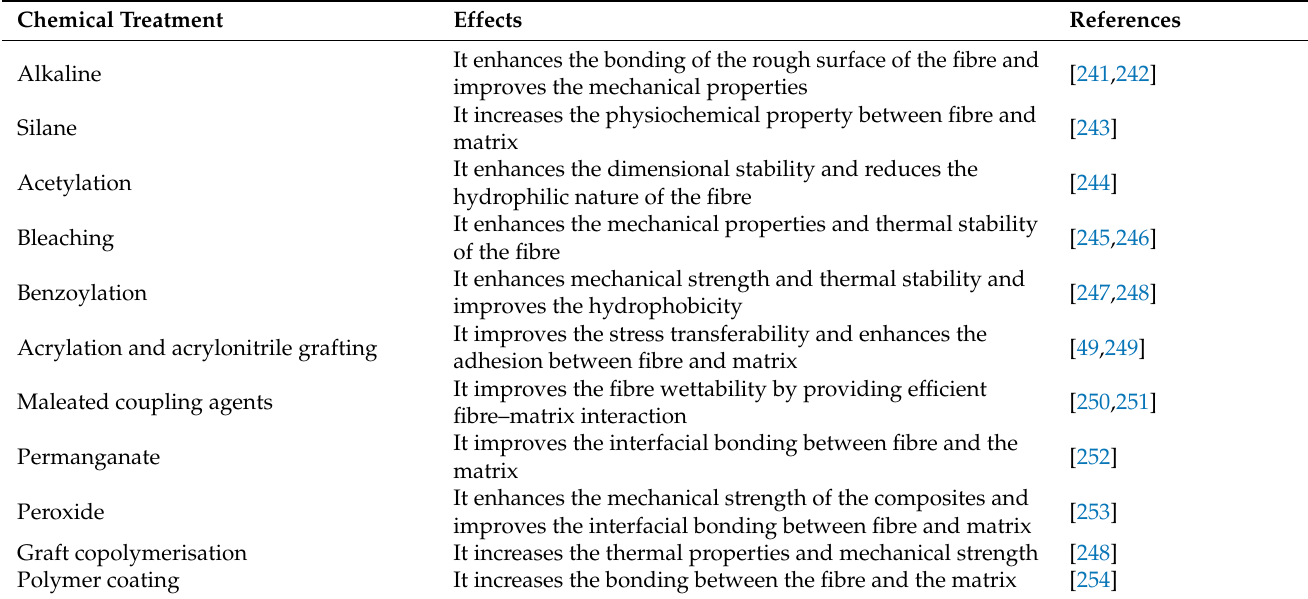
Table 9. Chemical treatments of natural fibres and their